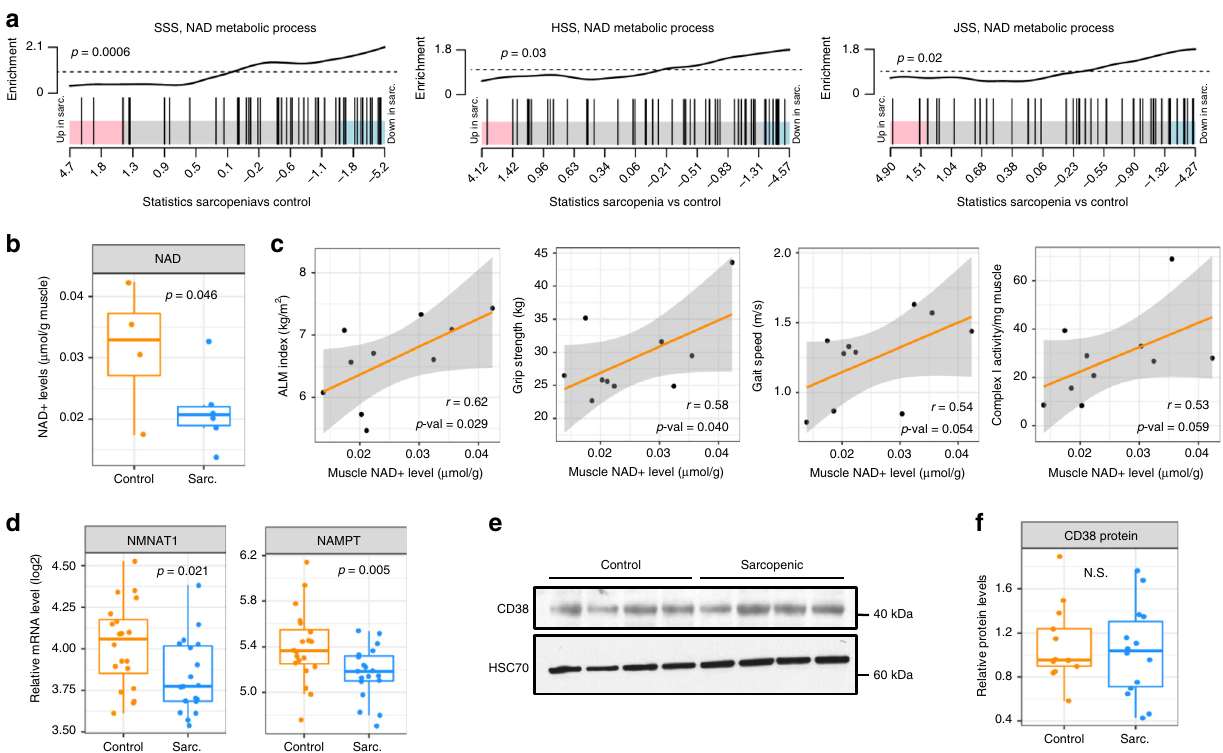
Fig. 6 NAD + levels are low in Sarcopenic muscle. a Gene-set enrichment plot of the “ NAD metabolic process ” (GO:0019674) on sarcopenic vs. control muscle mRNA in the discovery cohort (SSS, n = 19/20 per group) and 2 replication cohorts of different ethnicity (HSS, JSS; n = 4 – 28 per group as described in Supplementary Table 2). b NAD + levels in remaining muscle biopsies of control and sarcopenic participants (SSS cohort, n = 4 – 6 per group; p values based on t -statistics). c Muscle NAD + levels positively correlate to ALM-index, grip strength, gait speed, and mitochondrial complex I activity. Spearman rank correlation coef fi cient and its p value were calculated on n = 10 SSS muscle samples. d Muscle mRNA expression of NAD biosynthesis enzymes nicotinamide mononucleotide adenylyltransferase 1 ( NMNAT1 ) and nicotinamide phosphoribosyltransferase ( NAMPT ) (SSS cohort; n = 19 – 20 per group; p values calculated with moderated t -statistics). e , f Muscle protein expression of CD38 by western blot on remaining muscle samples of SSS cohort ( n = 13 – 14 per group; p values calculated with Mann – Whitney